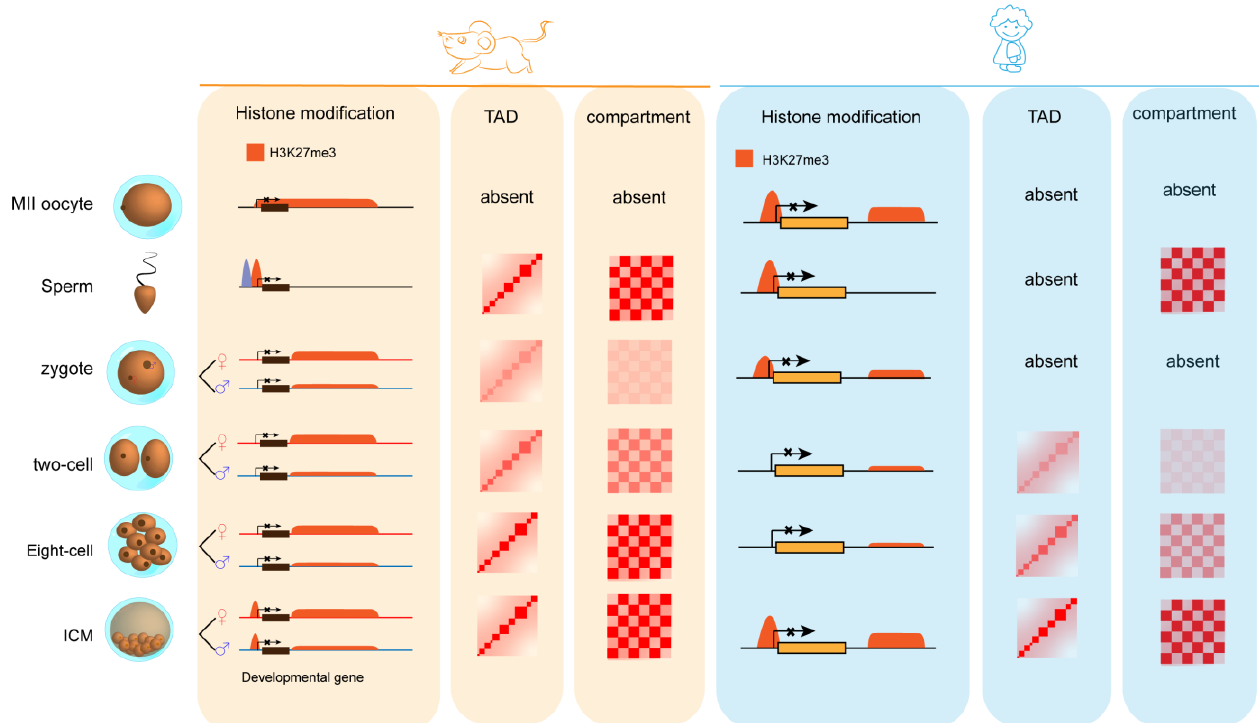
Figure 3. Gradual reconstruction of TADs and compartments during early embryonic development. Gradual reprogramming of epigenetic states and reconstruction of TADs and compartments during early embryonic development in a mouse ( left panel). Gradual reprogramming of epigenetic states and reconstruction of TADs and compartments during early embryonic development in a human ( right panel).